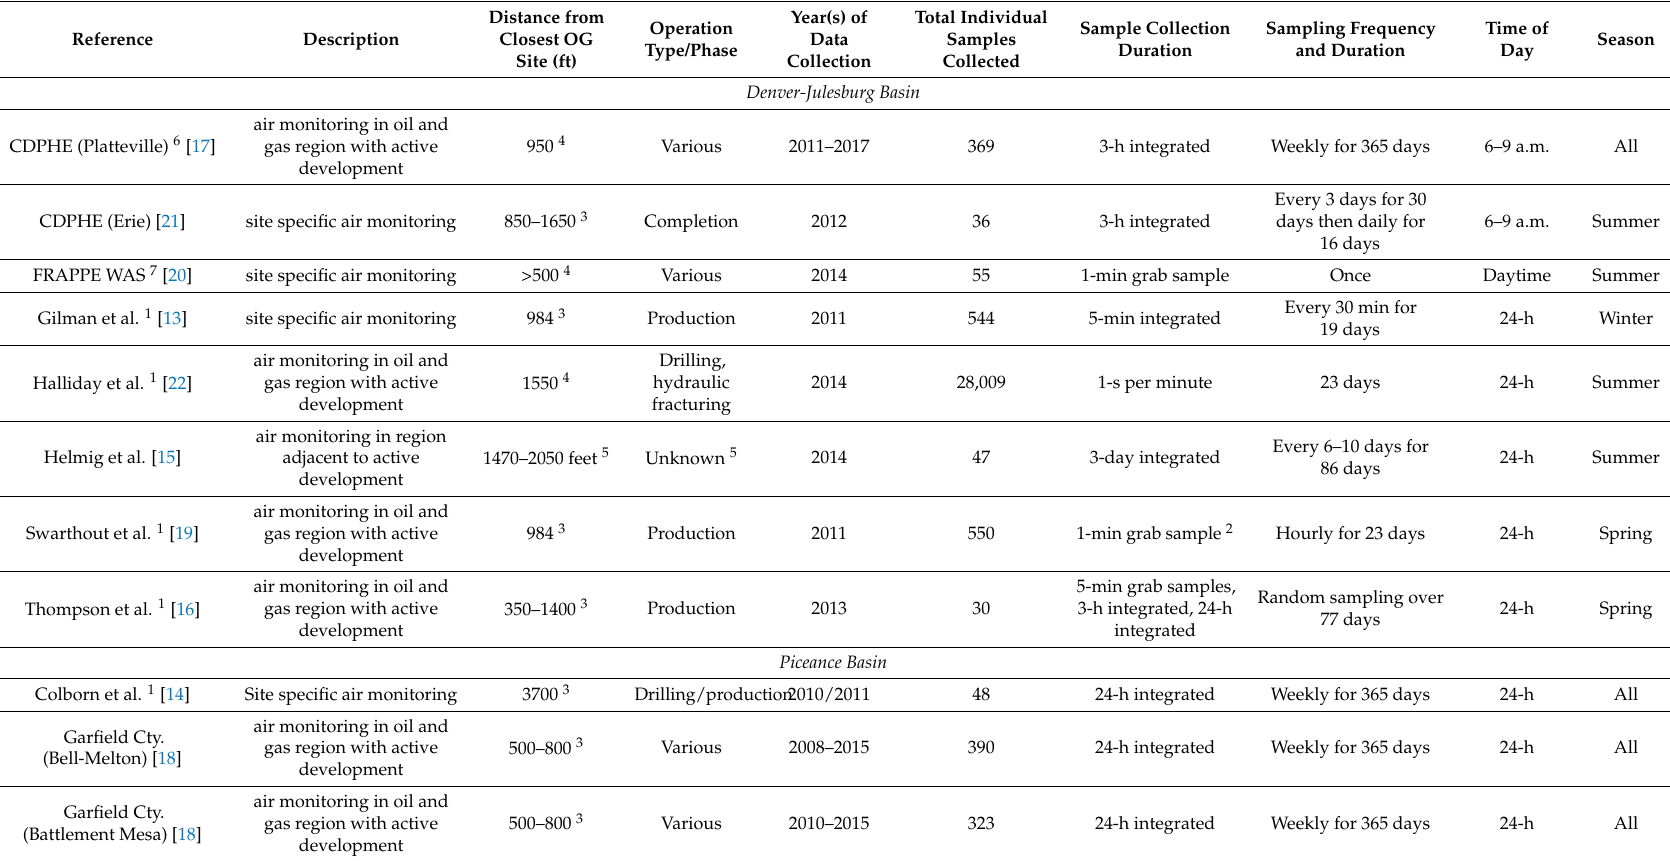
Table 1. Summary of ambient air monitoring studies used for risk